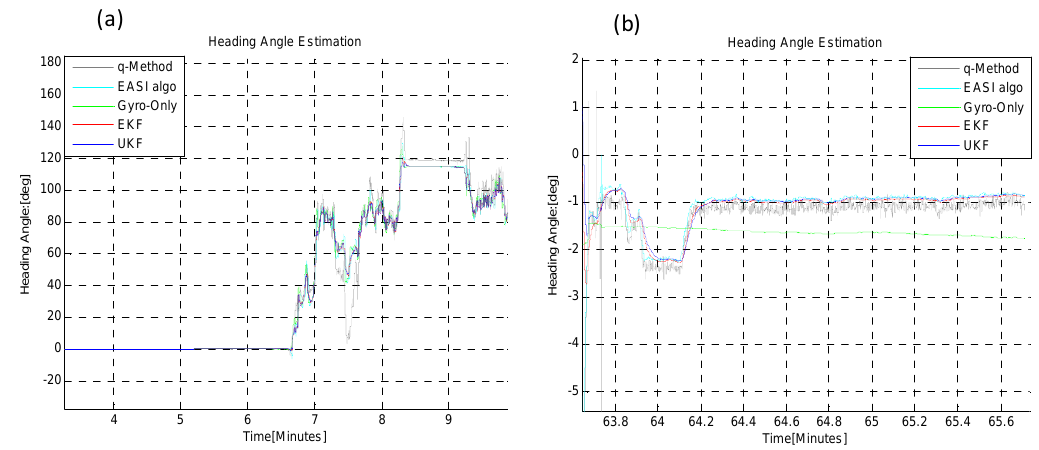
Figure 22. Zoom ‐ in view of Start ( a ) and End ( b ) heading angle estimation in the dynamic test of 1 h. The q ‐ Method is not in agreement with the other algorithms in the dynamic condition. However, in the static condition (e.g., before 6.5 min and after 63.8 min), the q ‐ Method also performs nearly as well, as expected.